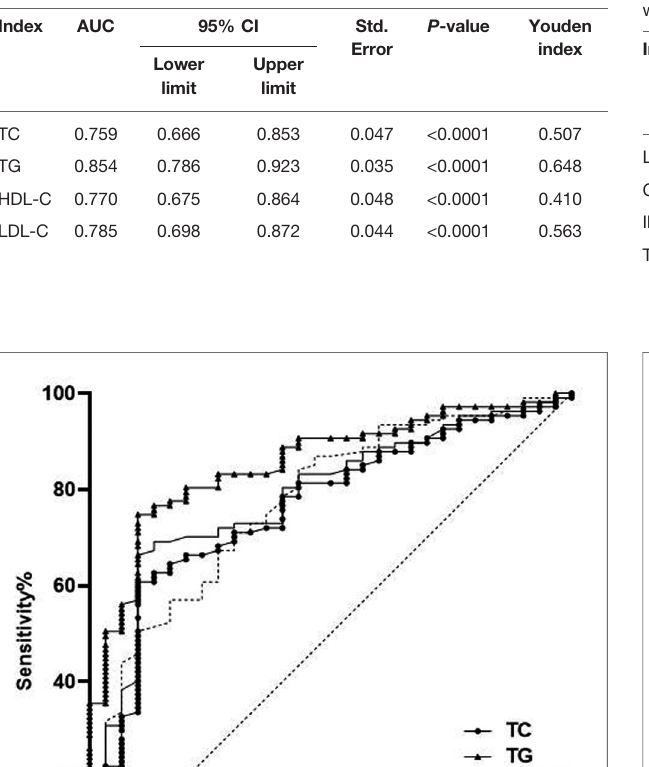
TABLE 2 | Predictive value of blood lipid level in pregnant women with HDP.